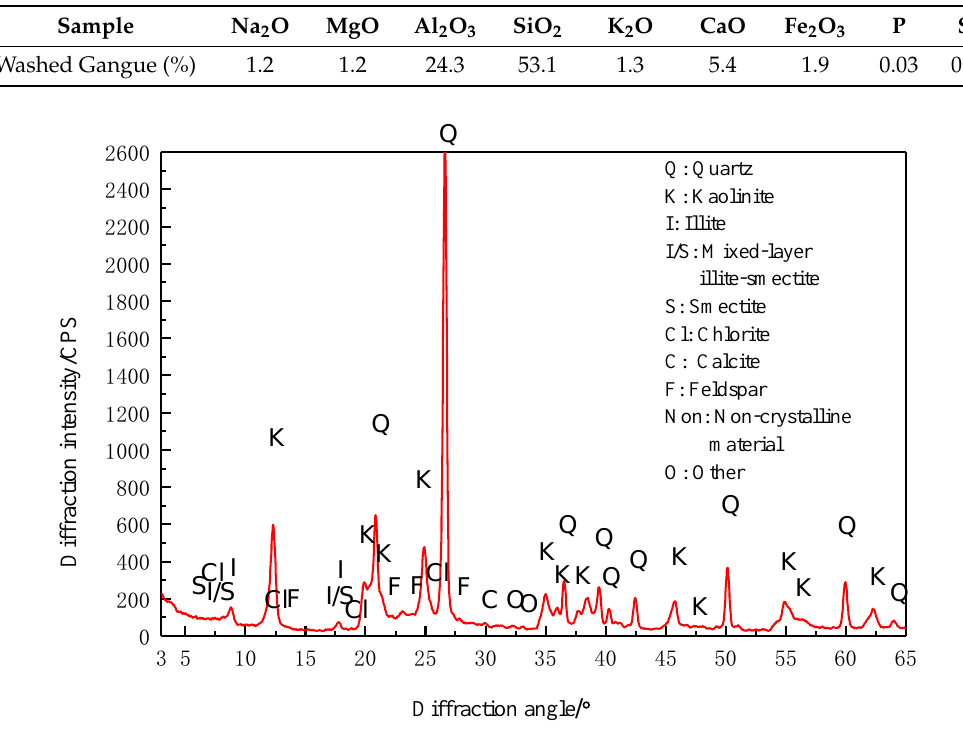
Figure 1. X-ray diffraction spectrum of washed gangue. Table 1. Chemical composition of washed gangue.